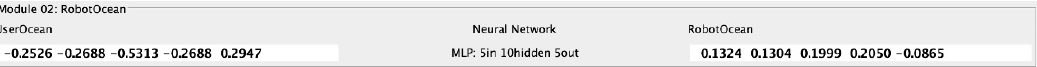
Figure 9. Example of module 02.